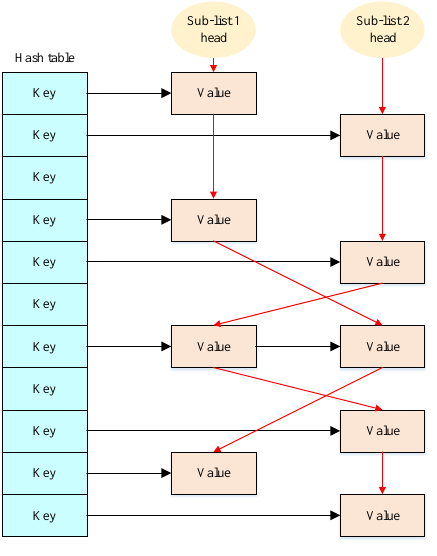
Figure 5. LRU data